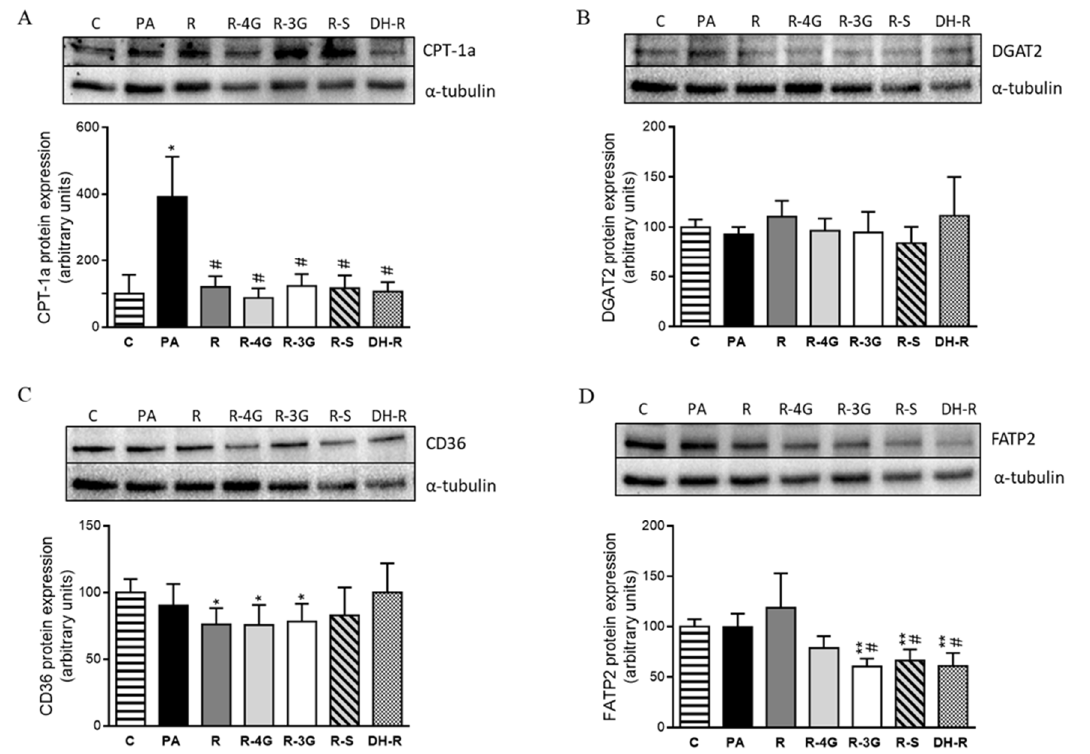
Figure 7. Protein expression of CPT-1a ( A ), DGAT2 ( B ), CD36 ( C ) and FATP2 ( D ) proteins in AML12 cells exposed to 0.3 M palmitic acid (PA) with or without resveratrol (R) or its metabolites (R-4G, R-3G, R-S and DH-R) at 1 µ M. The western blot bands shown are representative of 6 samples / group. CPT-1a, DGAT2, CD36 and FATP2 protein expressions were normalized by α -tubulin. Data are means ± SEM. * p < 0.05, and ** p < 0.01 vs. the control cells. # p < 0.05 vs. PA group. CPT-1a: carnitine palmitoyl-transferase 1a; DGAT2: diacylglycerol O -acyltransferase 2; CD36: fatty acid-transporter, and FATP2: very long-chain acyl-CoA synthetase 1.